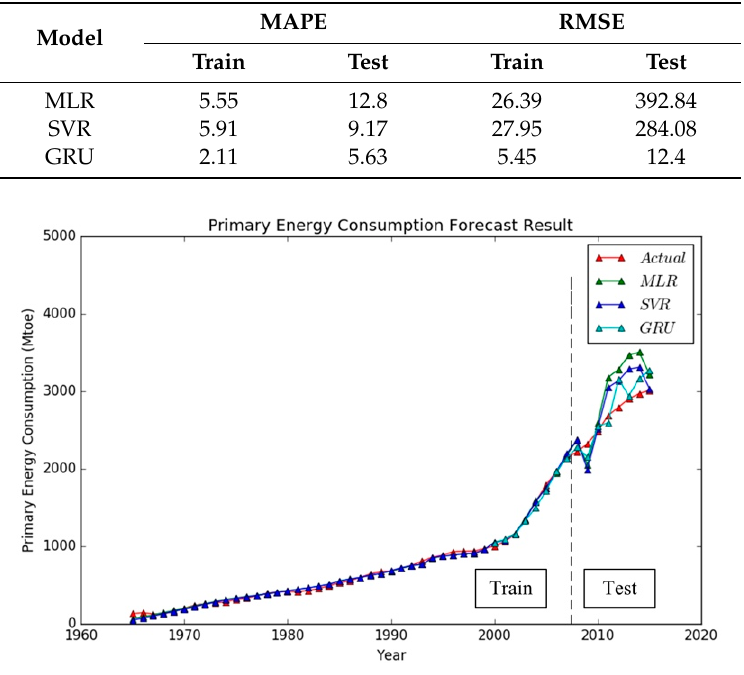
Figure 3. Comparison of actual and predicted Chinese energy consumption (2008–2015).